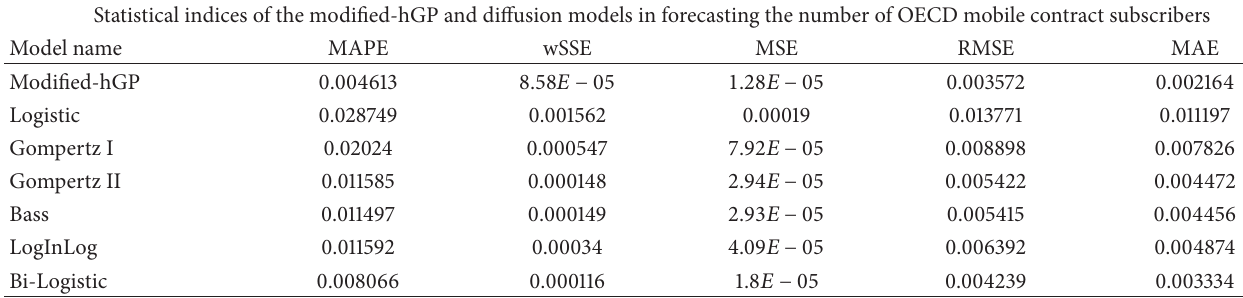
Table 8: Statistical indices in forecasting process of the modified-hGP and diffusion models for the number of OECD mobile contract subscribers.